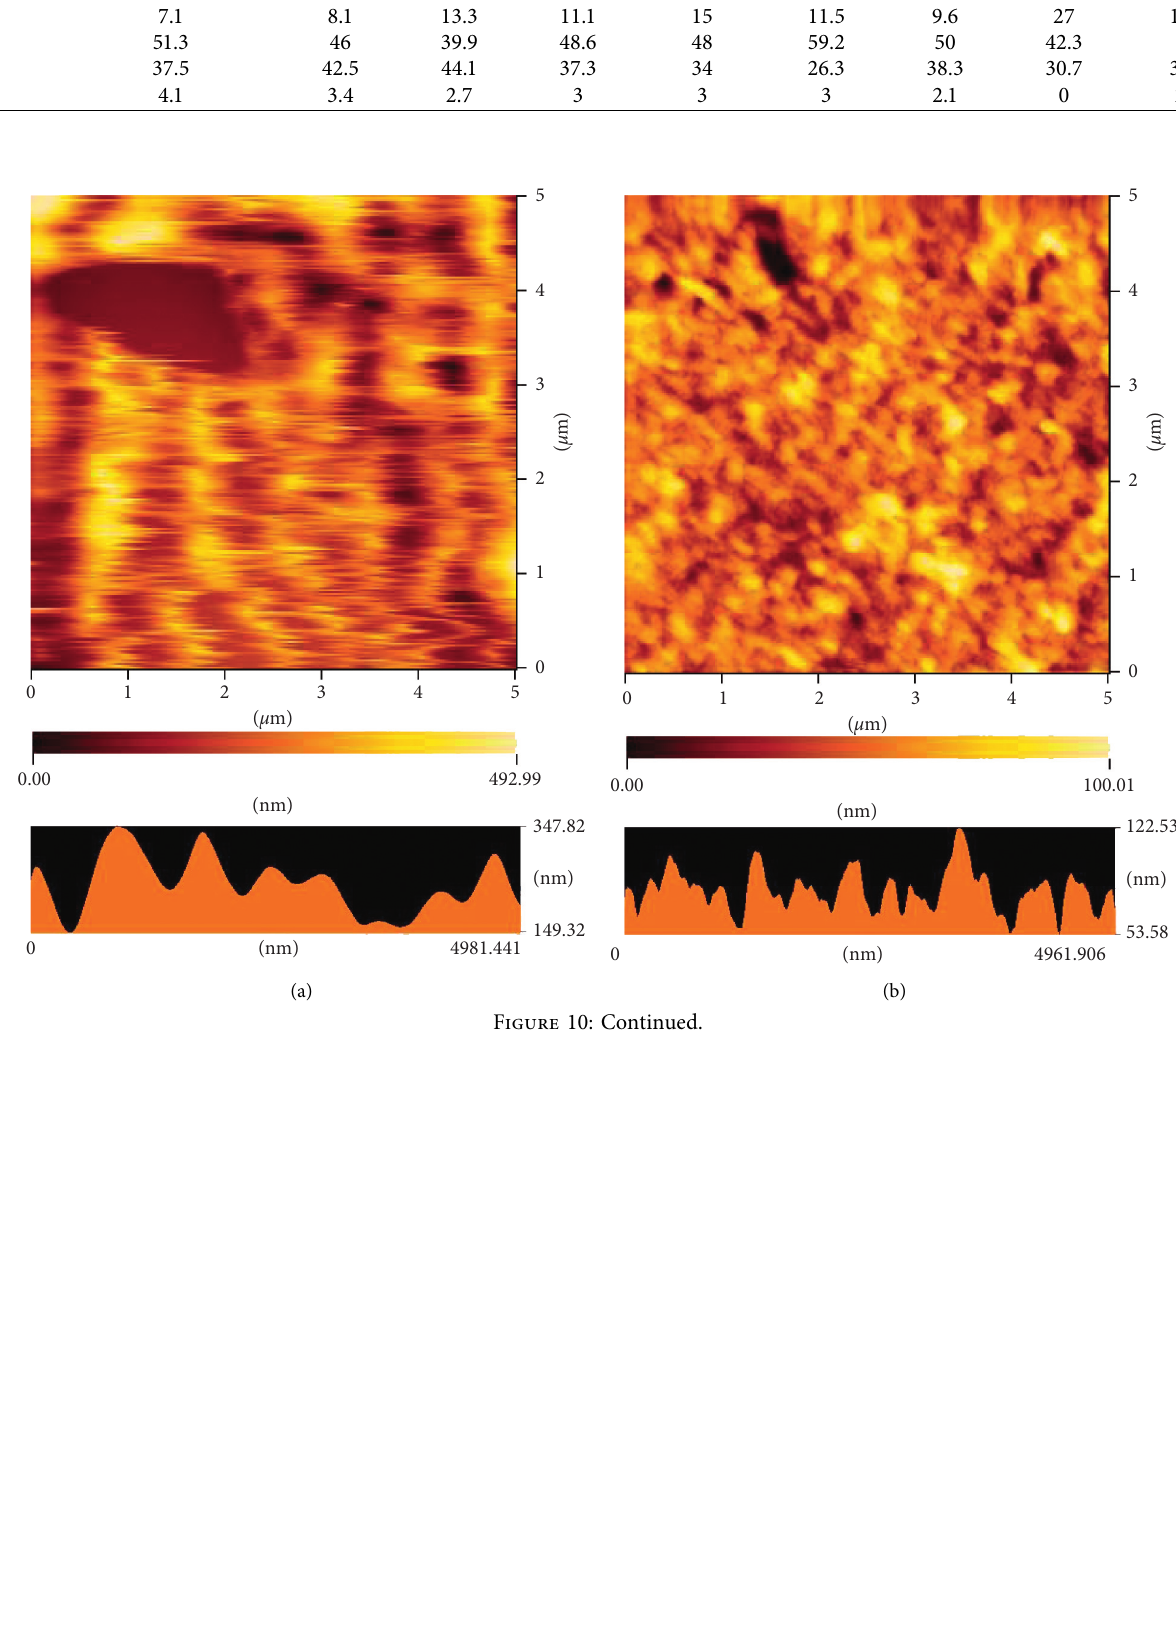
Table 2: Area portion (%) of the hydrogen bonding in the region of 3700–3000cm − 1 in the deconvolution FT-IR spectra. Peak